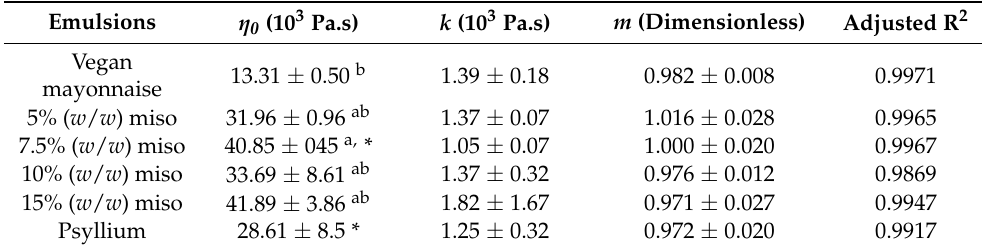
Table 5. Parameters ( η 0 , k and m ) and adjusted R 2 from Williamson’s model adjusted to the flow curves of standard and miso emulsions. Different letters indicate significantly different results ( p < 0.05) according to Tukey test. Different amounts of asterisks indicate significantly different results ( p < 0.05) according to t -test.